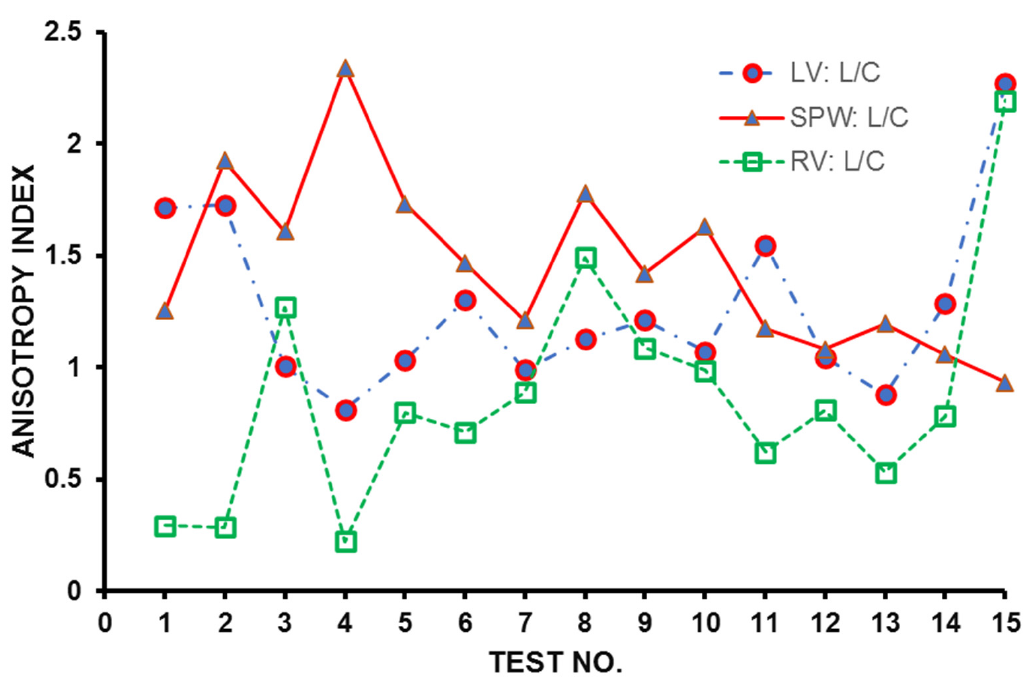
Figure 8. Anisotropy indices calculated over all tests for each heart wall.